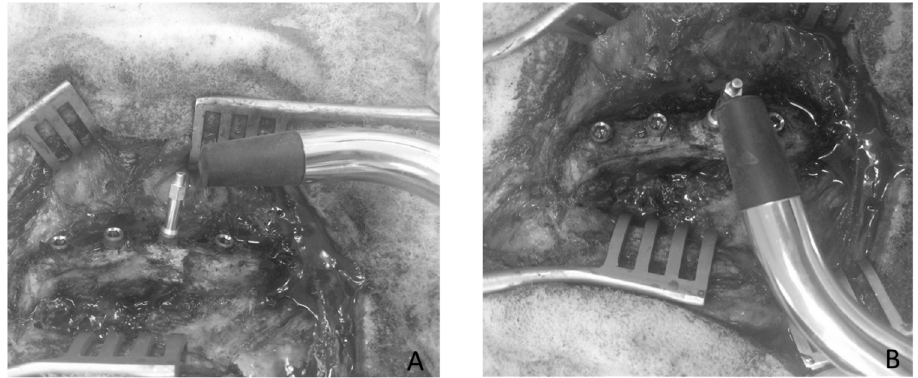
Figure 4. Measurement configuration of the implant stability quotient (ISQ) using the resonance frequency analysis (RFA) device realized in two perpendicular directions (( A ) 0° and ( B ) 90°).